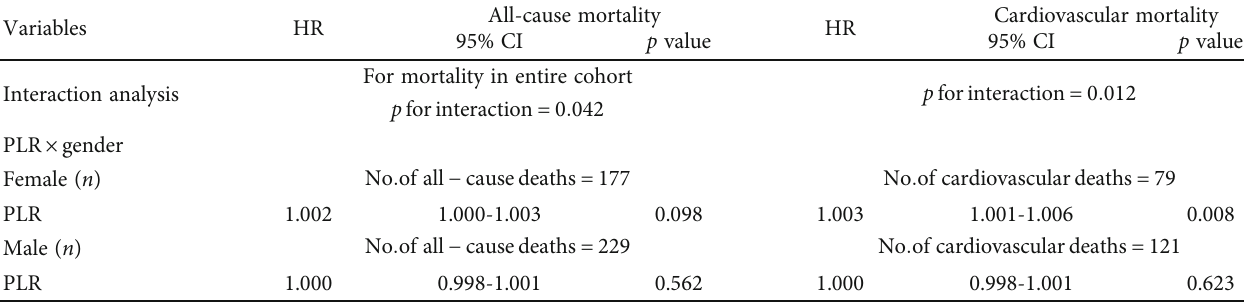
Table 4: Interaction tests of PLR and gender and mortality, and the sexual di ff erence in the associations between PLR and mortality ∗ . Variables